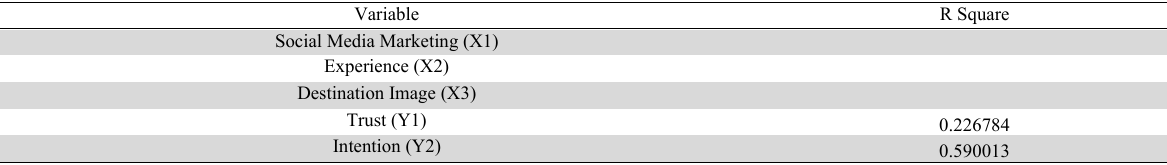
Evaluation of the Inner Structural Model